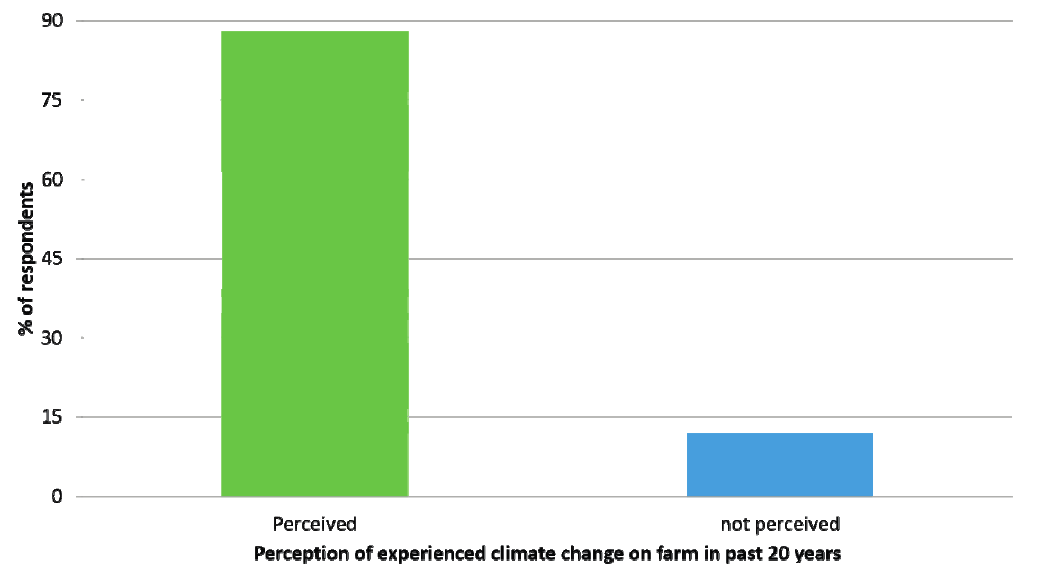
Figure 1. Proportion of respondents by self-reported experience of climatic change.